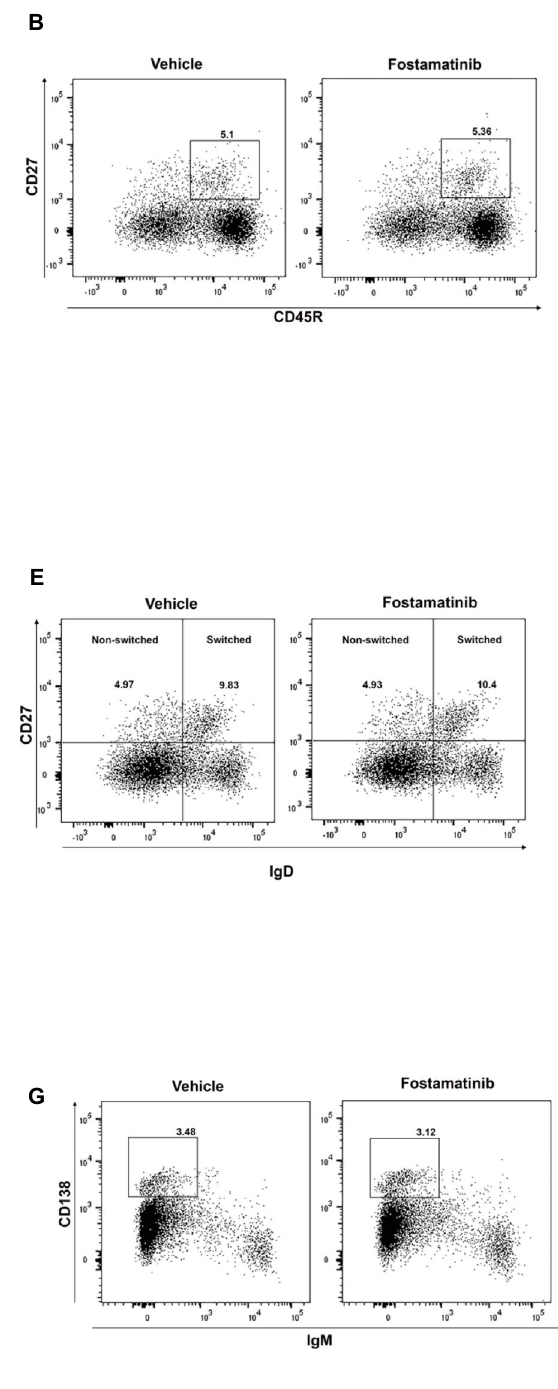
Figure 4. Fostamatinib treatment did not affect B cell or plasma cell populations. Flow cytometry was used to measure mature B lymphocytes populations in fostamatinib treated and vehicle treated sensitized LEW rats. Each graph shows number of cells per gram of spleen. Mature B lymphocyte numbers remained similar between treatment groups. ( A ) Memory cells were defined as CD45R + CD27 + , ( C ) switched cells as CD45R + CD27 + IgD − , ( D ) non-switched cells CD45R − CD27 + IgD + , ( F ) plasma cells as IgD − CD45R − IgM − CD138 + . (n = 6 rats/group). Graphs show cell numbers per gram of spleen (n = 6 rats/group). Representative flow cytometry data of ( B ) memory B lymphocytes ( E ) switched and non-switched B lymphocytes ( G ) plasma cells. Number shown represents percentage of cells in gate. Blue filled circle—vehicle, red filled